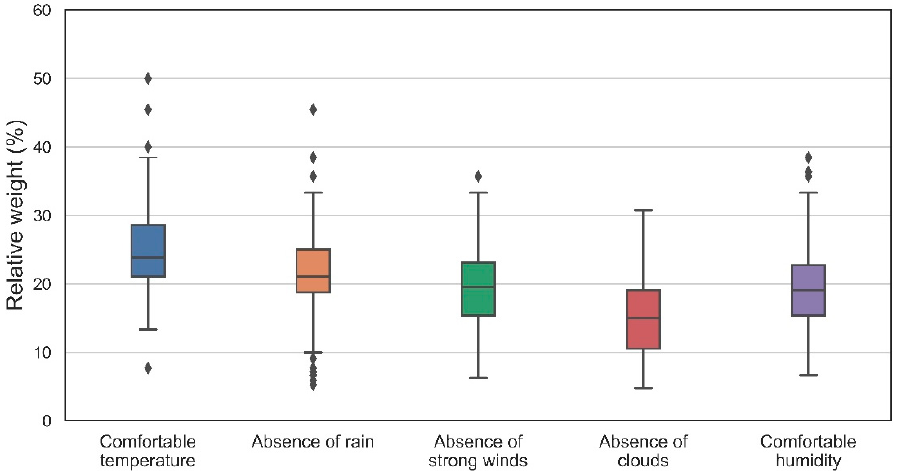
Figure 4. Weights of the different climate variables in the context of urban tourism, derived from the present survey. The whiskers indicate the maximum and minimum values, excluding the outliers. The horizontal black line indicates the median, while the range of the box height displays the upper and lower quartile. The rhombus points indicate the outliers.